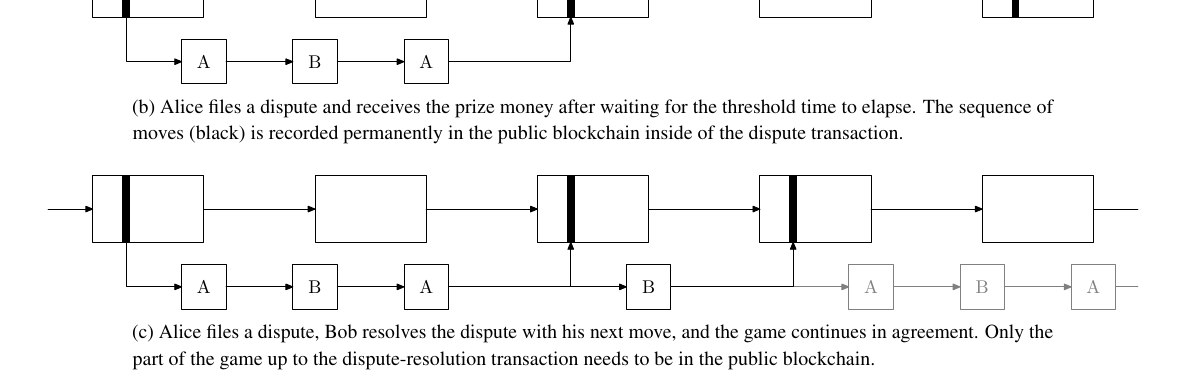
Fig. 3. Sketch of the blockchains involved for a game channel in various scenarios. The chain on top is the public blockchain, while the chain below is the private chain containing blocks mutually created and signed by Alice and Bob (marked with “A” and “B”, respec- tively). The dark bars indicate transactions related to the game channel included in the public